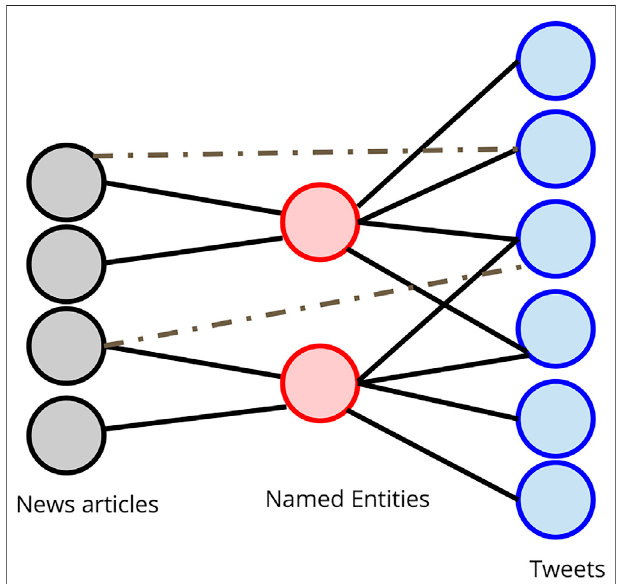
FIGURE 3 | Tripartite graph schema.